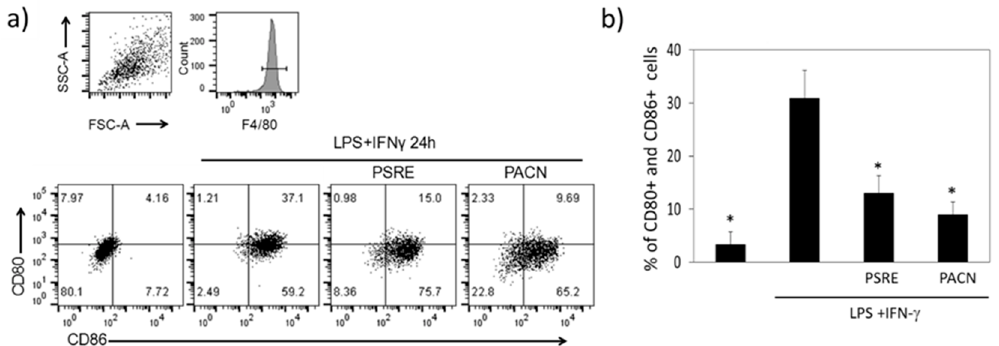
Figure 7. Expression of proinflammatory cell surface markers CD80 and CD86 analyzed by flow cytometry 24 h after treating LPS + IFN γ -activated BMDMs with PSRE and PACN. ( a ) Characteristic mouse macrophage marker F4/80-positive cells were gated for double CD80 and CD86 analysis as a measure of M1 macrophage phenotype (top right small quadrant). Representative plots of a total of three independent experiments in three replicates are presented in the bottom. ( b ) Mean ± SD of three independent measurements in three parallels. Differences between the measurements were tested using a one-way ANOVA followed by a Tukey's multiple comparison test. *—significantly different from the LPS and IFN- γ treatment ( p < 0.05).